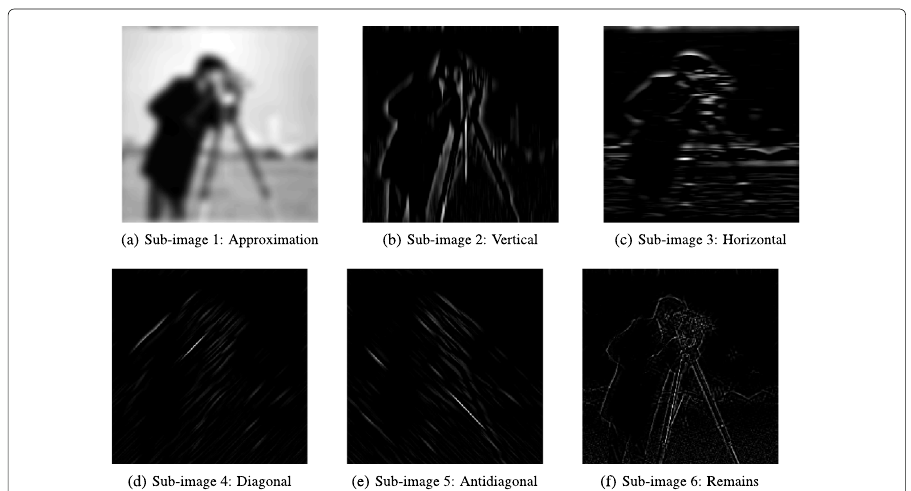
Fig. 14 The sub-images1–6 of the “Cameraman” image produced by the “ SSA-iSBD6-channelfilterbank ” with L = 12